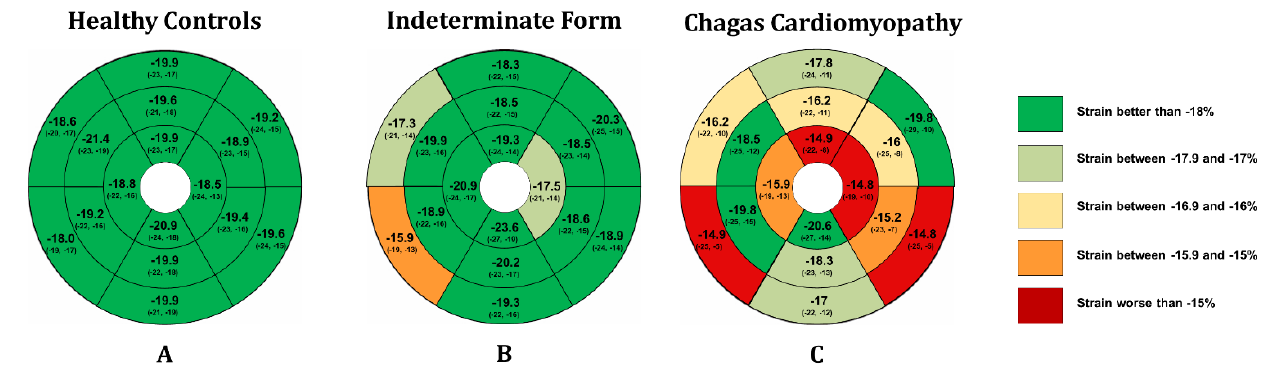
Figure 2. Longitudinal strain bull’s eye plot patterns in each of the assessed groups.